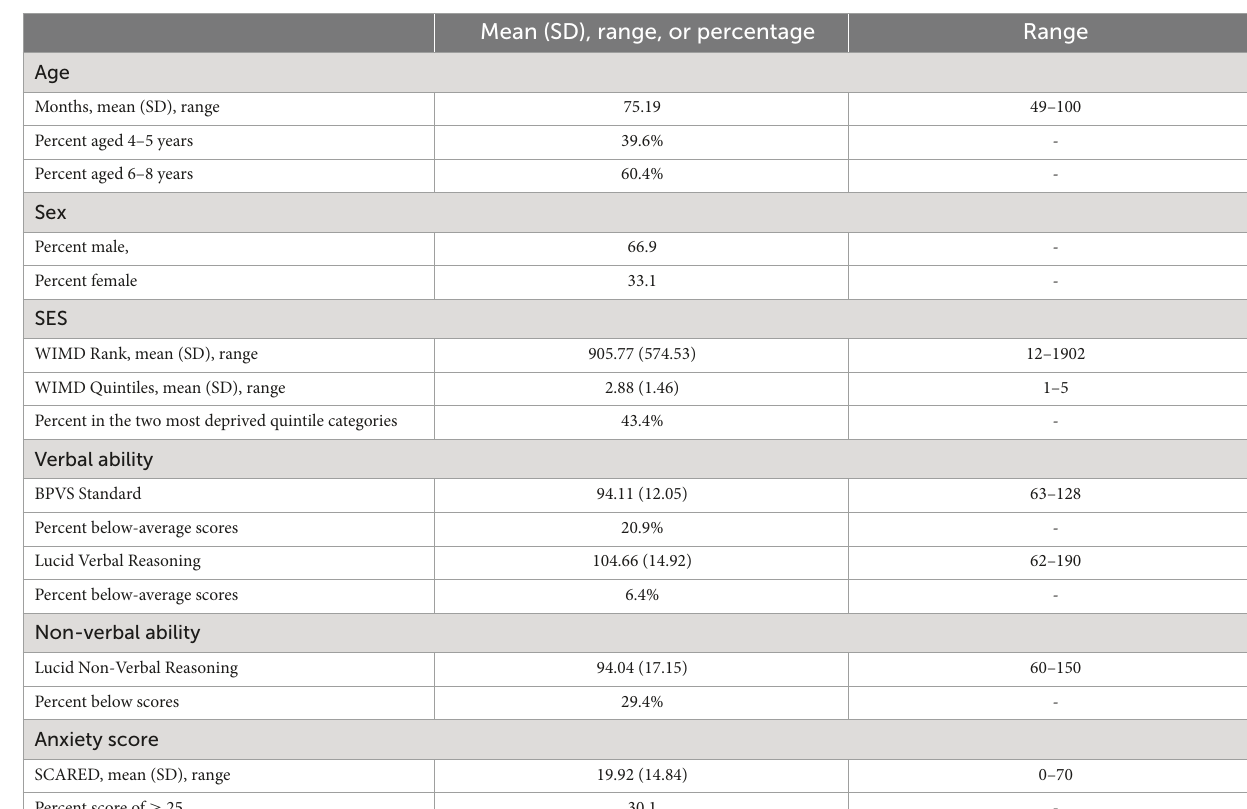
TABLE 1 Characteristics of sample, age, sex, SES, verbal, and non-verbal ability and